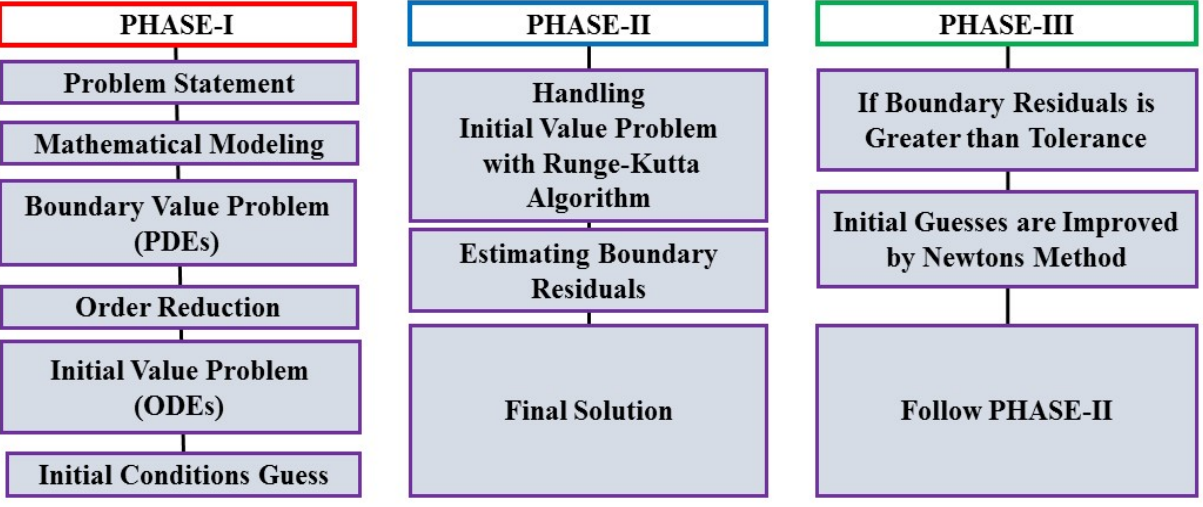
Figure 2. Description of numerical method.